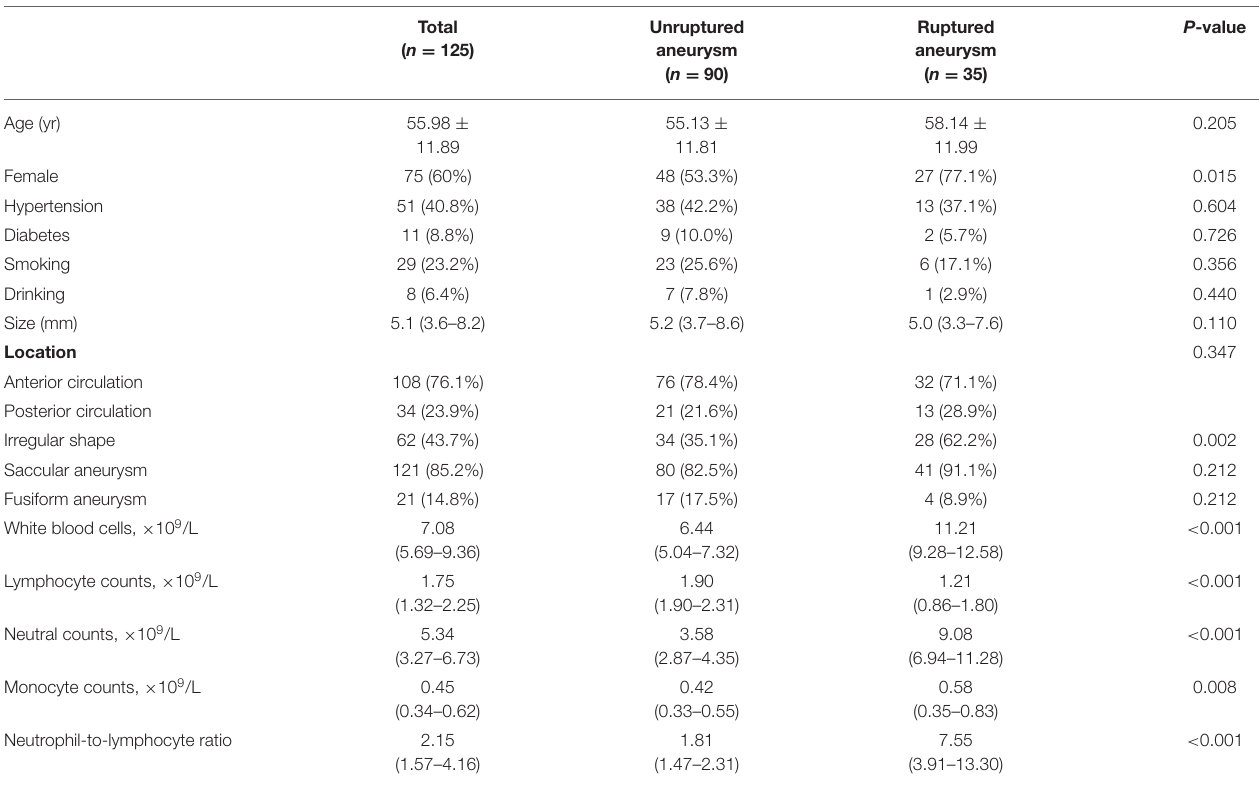
TABLE 1 | Characteristics of ruptured and unruptured intracranial